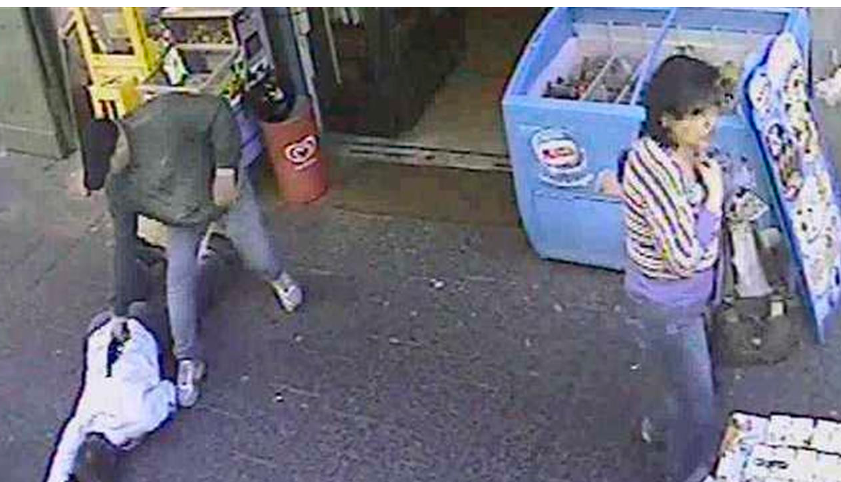
Figure 1. Frame from footage taken on 1 May 2009 with a video-surveillance system, which records the murder of Mariano Bacioterracino in the Sanità neighbourhood of Naples. (Available at: ubblica.it/cronaca/l-esecuzione-di-mariano-bacioterracino/38503/38650, last accessed: 21 August 2017).